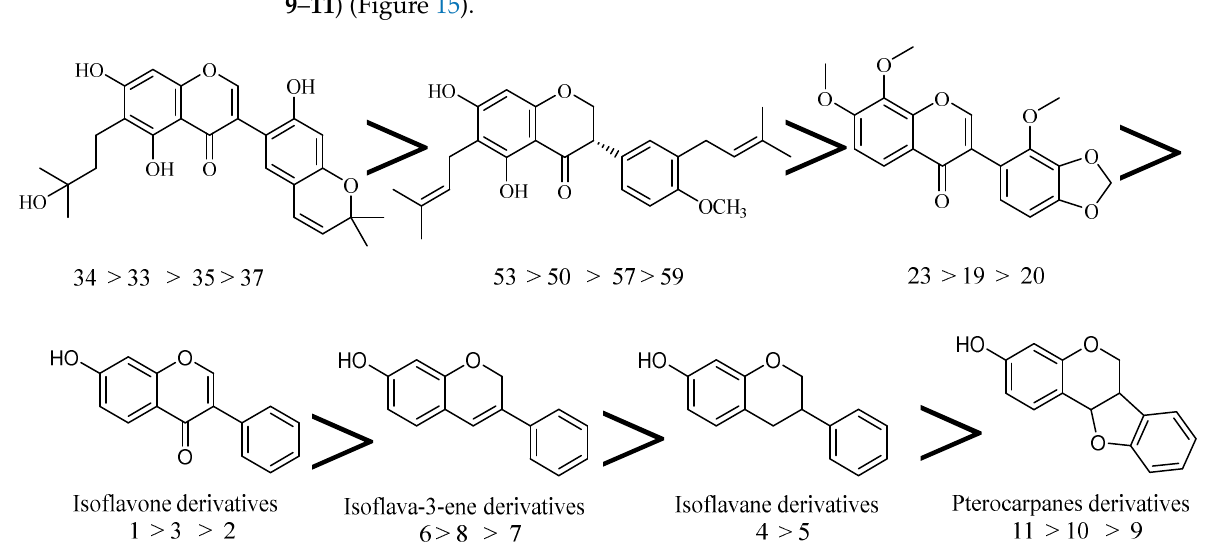
Figure 15. Schematic diagram showing the different affinities of isoflavonoids against hACE-2. For isoflavone derivatives (compounds 34 , 33 , 35 and 37 ), it was found that compound 34 incorporating 3-hydroxy-3-methylbutyl moiety at 6-position was more active that com- pound 33 incorporating 3-methylbut-2-en-1-yl moiety at the same position. The latter was more active than compound 35 incorporating 2-hydroxy-3-methylbut-3-en-1-yl moiety at the same position. Compound 37 incorporating 3-methylbut-2-en-1-yl moiety at 8-position was less active than the corresponding